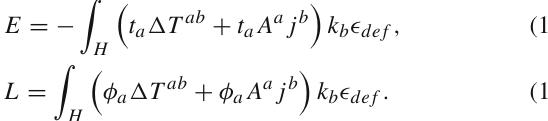
Fig. 4 A spacetime diagram representing charged matter falling into a black hole Contracting Eq. (96) by any Killing field ξ b and using the Killing equation ∇ ( a ξ b ) = 0, we can rewrite Eq. (96) as ∇ a